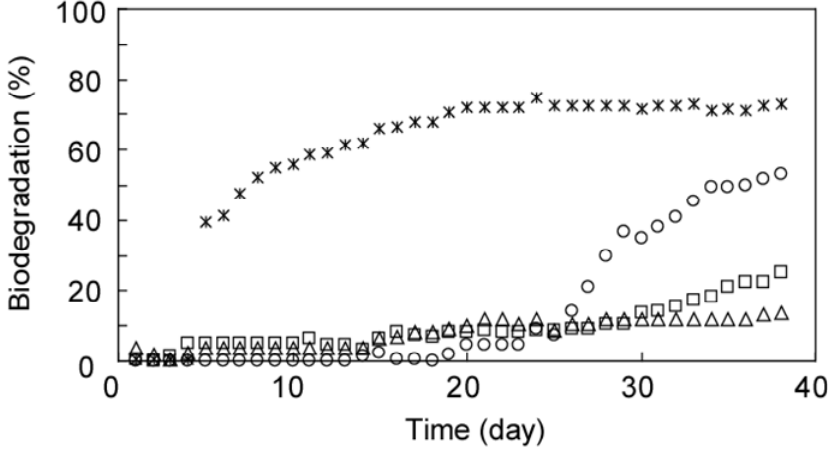
Figure 11. BOD-biodegradation of PHS/M-6 with various HM-6 contents [0 mol% ( △ ), 6 mol% ( □ ), 17 mol% ( ○ )] and aniline (*) using activated sludge at 25